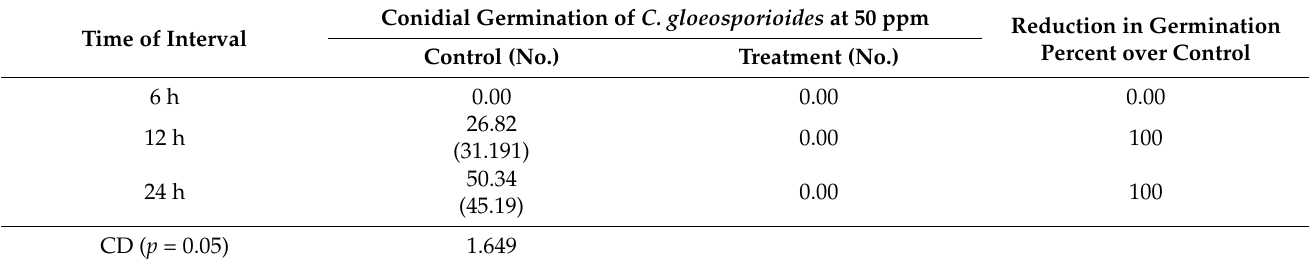
Table 6. Testing the effect of benzothiazole (50 ppm) on germination of spores of C. gloeosporioides . Conidial Germination of C. gloeosporioides at 50 ppm Time of Interval